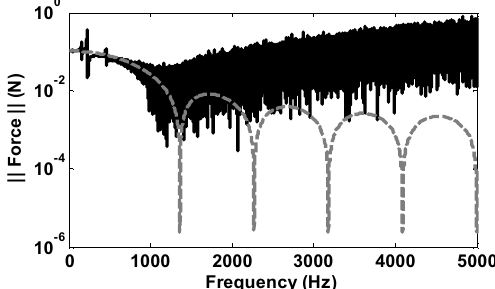
Fig. 10. Comparison of the original force estimate (——) and the actual force (– – –) for a frequency range from zero to half the sampling rate.